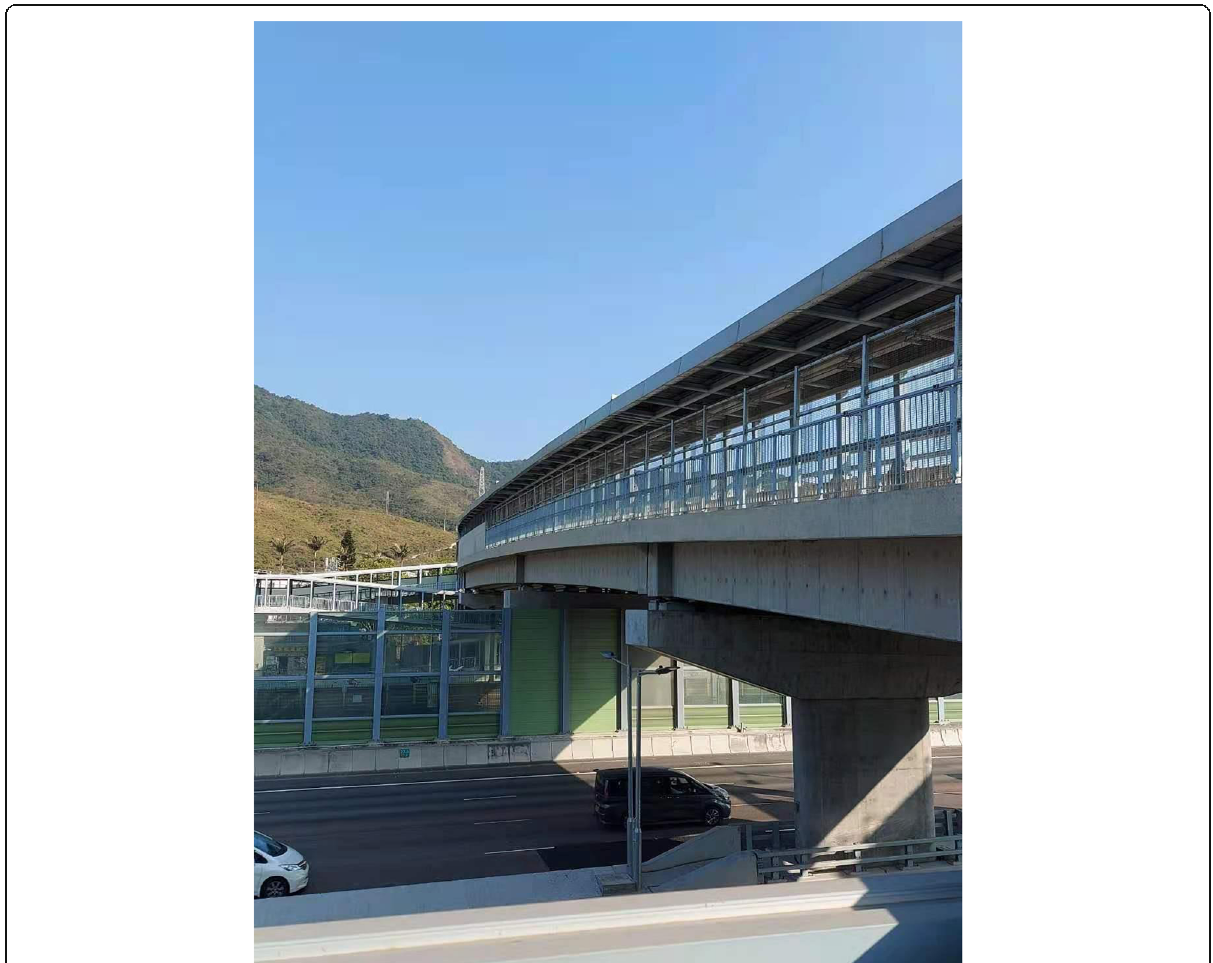
Fig. 2 The current design of highway overpass for pedestrian